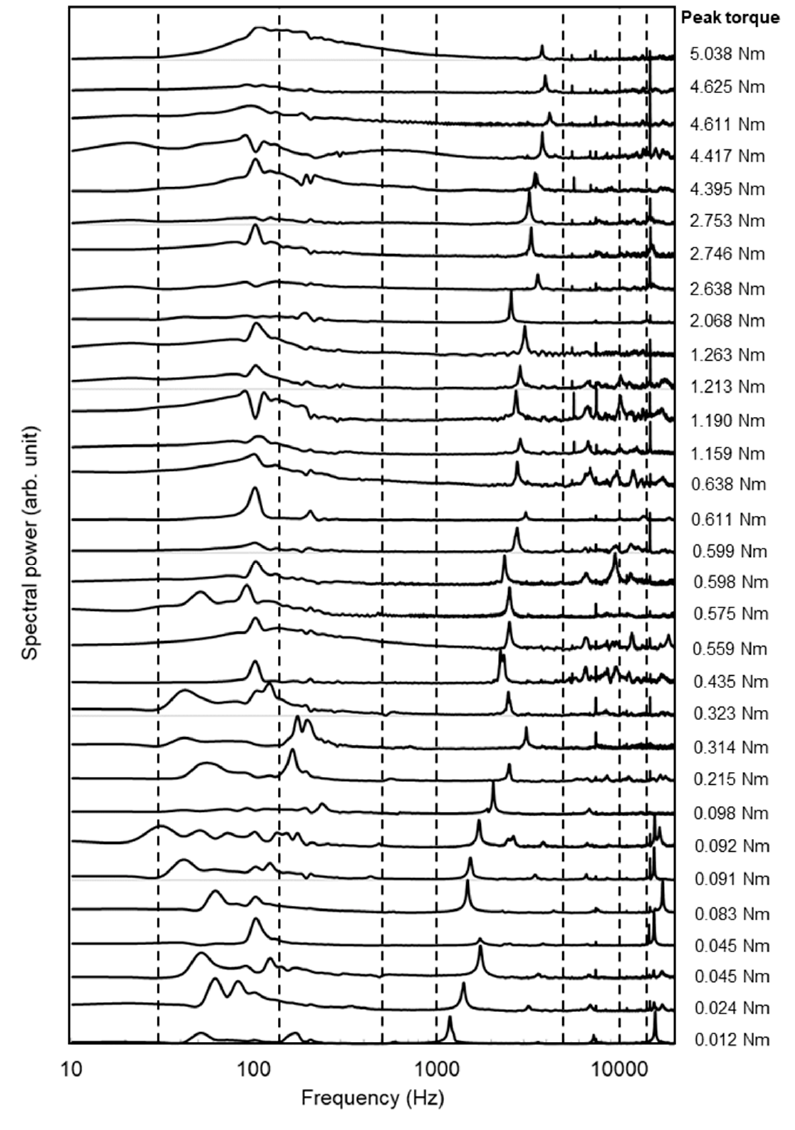
Figure 8. Laser-induced vibration spectra for monoaxial pedicle screws reported in [10]. The dashed lines show analysis ranges for calculations of each explanatory variable. Table 1. Result of explanatory variable selection by Lasso for monoaxial pedicle screw reported in the previous study [10]. These explanatory variables extracted more than 50% of the samples of trials. Number of Selections